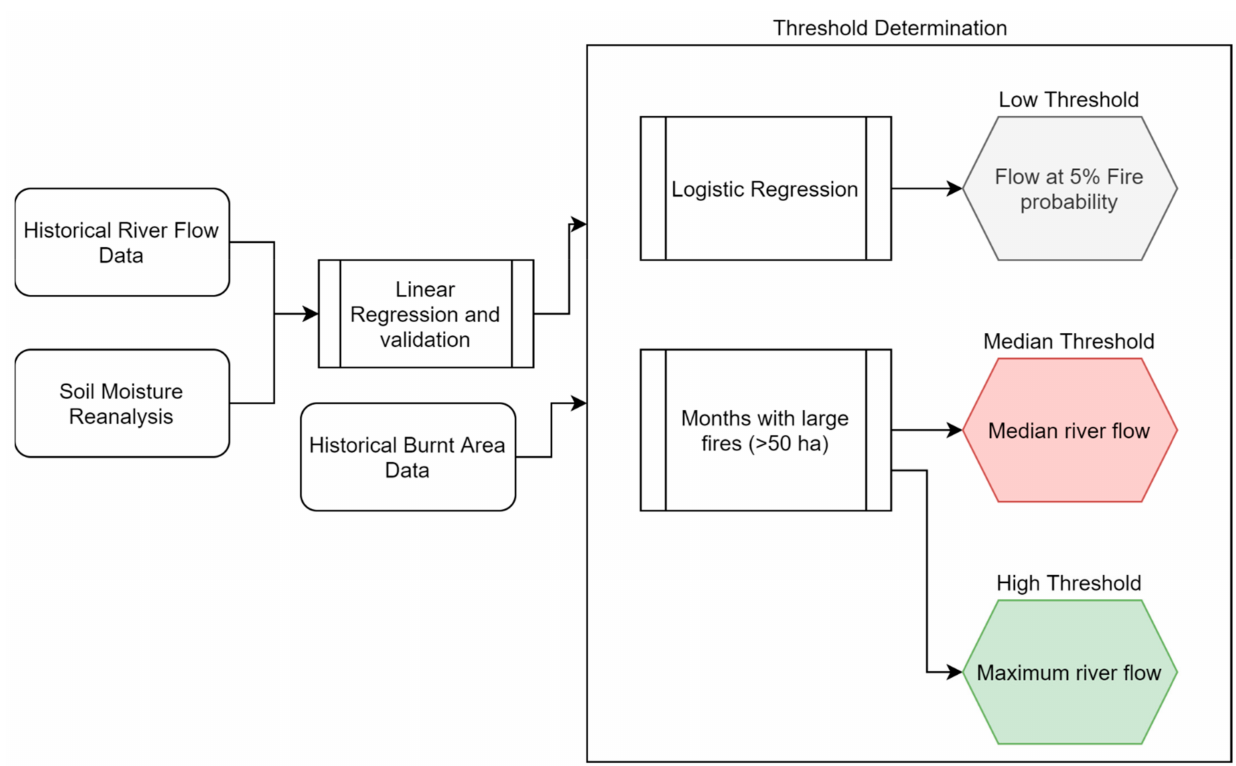
Figure 2. Flow diagram showing the steps taken to use river flow to develop thresholds that estimate forest fire risk using river flow data in the Tasmanian Wilderness World Heritage Area. Data input is historical river flows for the Franklin and Davey Rivers, historic burnt forest area surrounding each river catchment, and soil moisture derived from the BARRA meteorological reanalysis. Analytical steps are provided in the